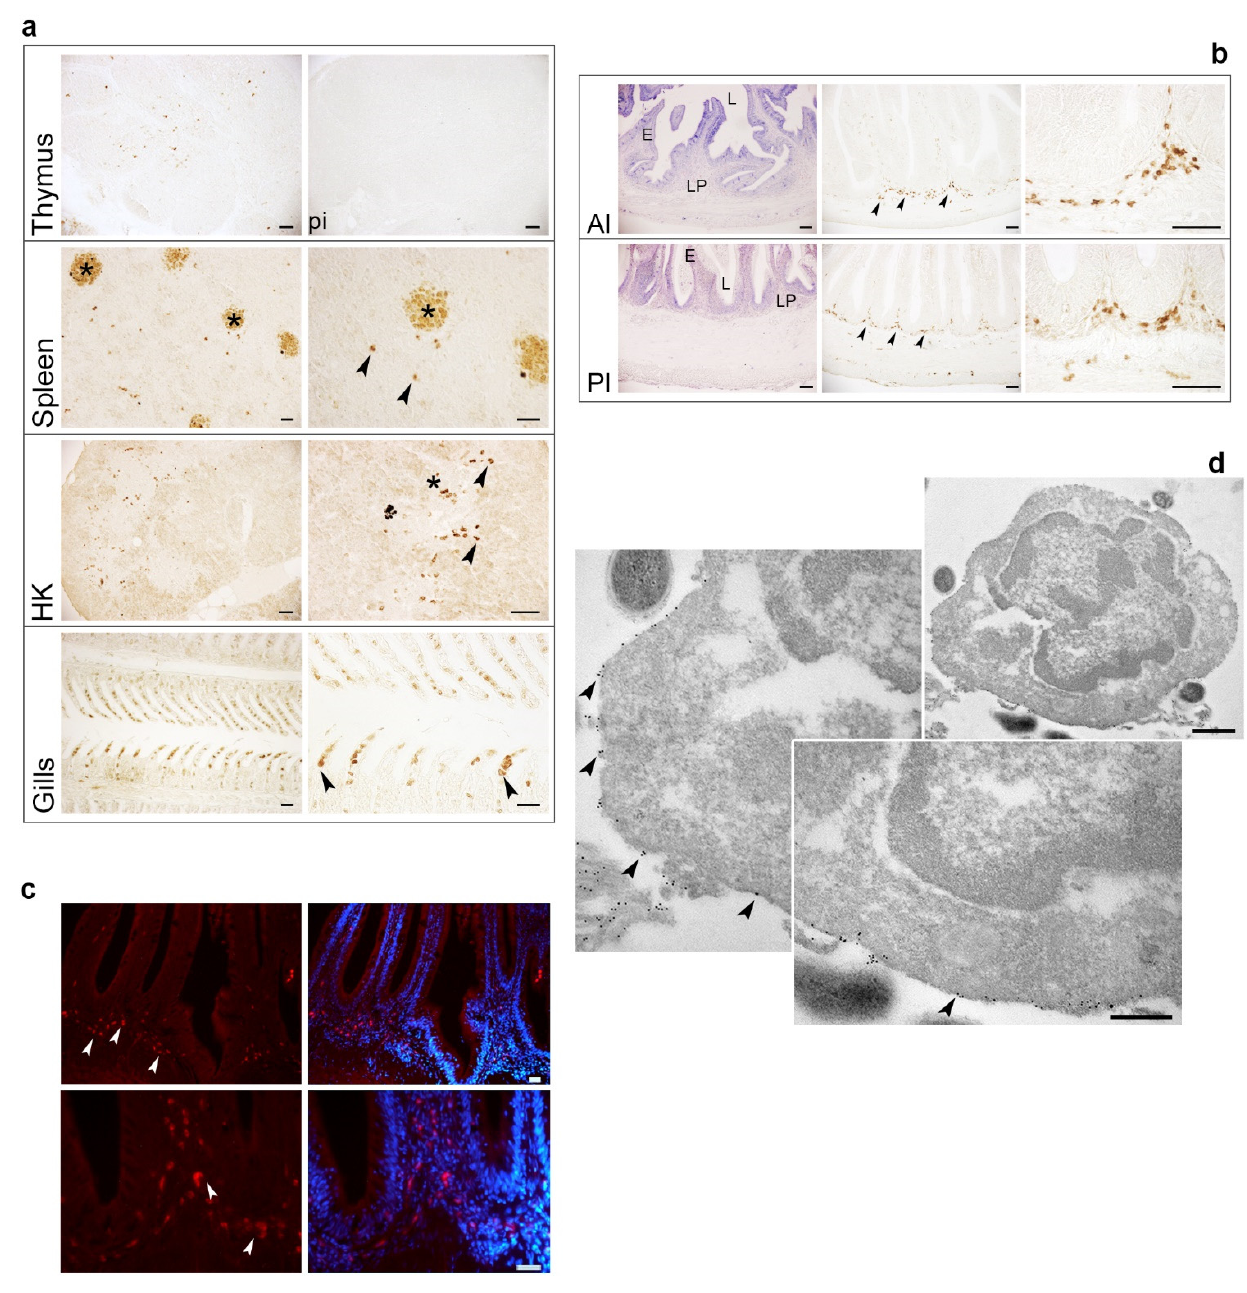
Figure 4. Localization of TR γ + cells in lymphoid organs and mucosal tissues of one-year-old fish. ( a , b ) Immunohistochemistry photographs of thymus (scale bars: 50 μ m), spleen (scale bars: 20 μ m), HK (scale bars: 50 μ m), gills (scale bars: 20 μ m) and intestine (scale bars: 50 μ m) of one-year-old fish. Asterisks in spleen and HK photographs indicate MMCs. LP, E and L in intestine photographs indicate lamina propria, epithelium and lumen, respectively. Black arrowheads are examples of TR γ + cells. ( c ) Indirect immunofluorescence analysis on posterior intestine sections. Examples of immunoreactive cells are indicated by white arrowheads. Scale bars are all 20 μ m. ( d ) Pre-embedding immunogold labelling of cell surface TR γ . Examples of electron-dense gold nanoparticles are indicated by black arrowheads. Scale bars are 500 and 250 nm for the lower and greater magnification photographs, respectively.